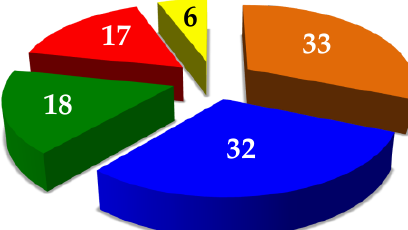
Figure 8. Distribution of the 106 proteins identified in the T. molitor extract, according to their potential functions: proteins with a functional role (33, orange), enzymes (32, blue), proteins with a structural function (18, green), muscle proteins (17, red), and proteins with other roles (6, yellow).